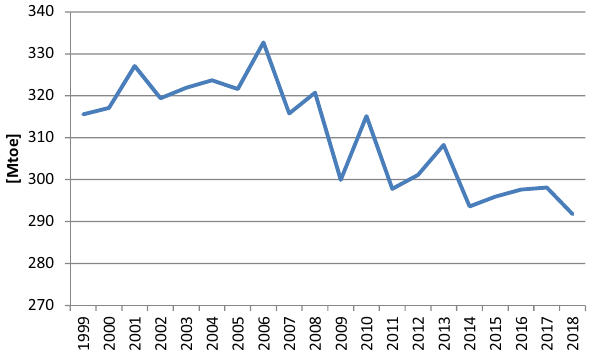
Figure 4: Primary energy consumption in Germany in the years